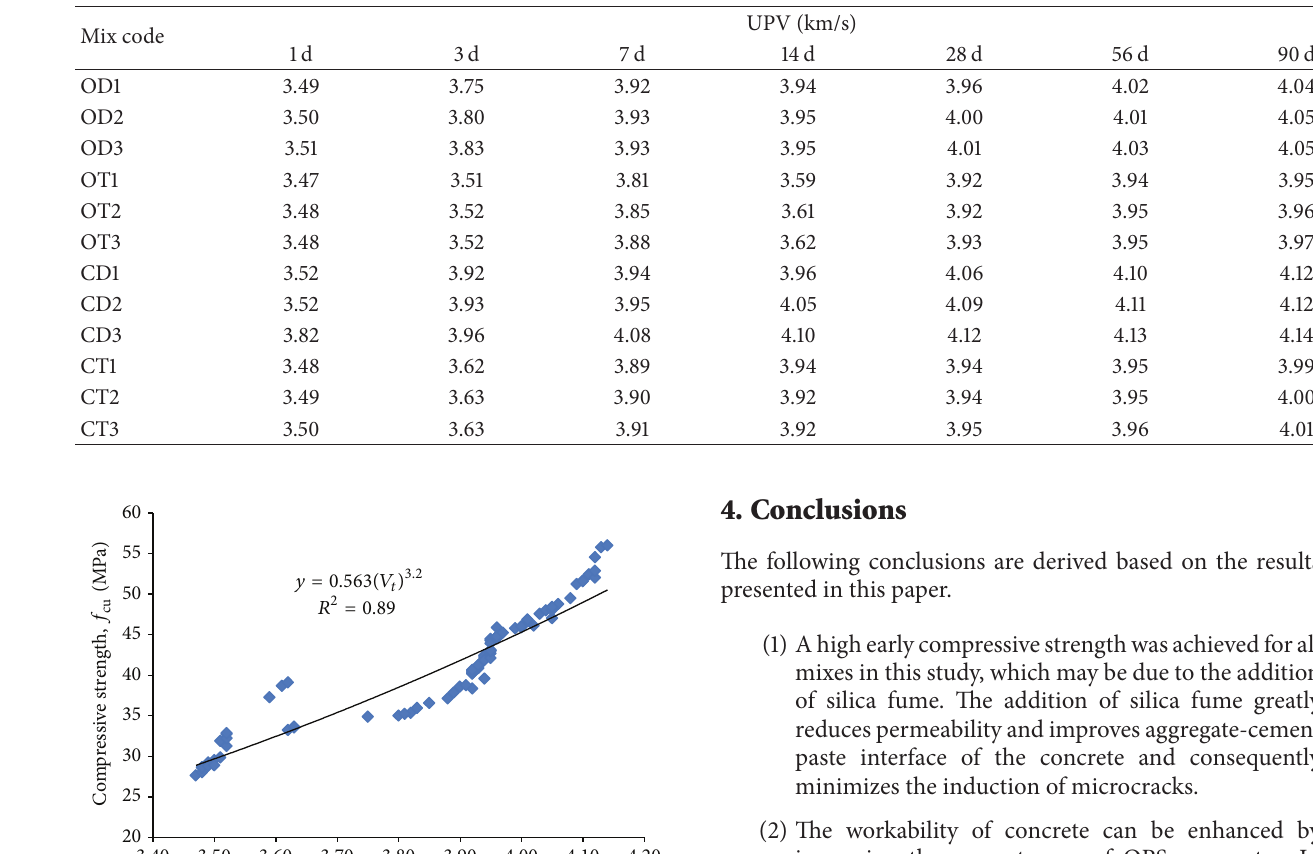
Table 6: Ultrasonic pulse velocity (UPV) for concrete mixes made from different OPS species and age categories.